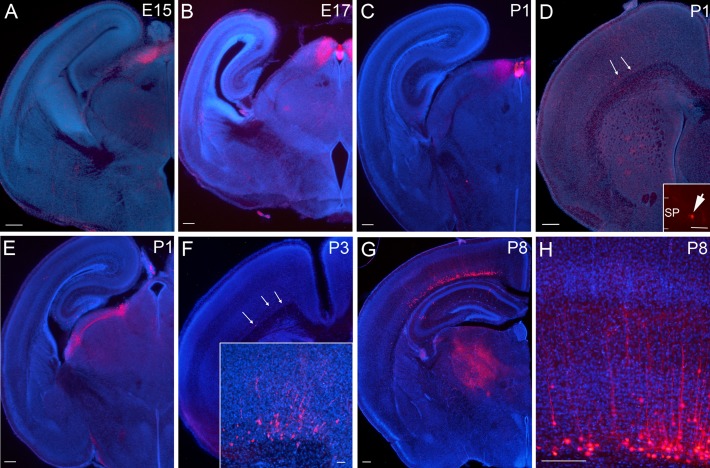

Drd1a-Cre expression in the brain visualized by tdTomato labeling in Drd1a-Cre; Ai14 mouse from embryonic development until P8. (A,B) At E15 and E17, Cre-expressing cells are restricted to a small area of the dorsal thalamus, no Cre+ cells are found in the cerebral cortex. In caudal sections the labeled regions are in contact with the aqueduct, from where they continue anteriorly in a dorsal position. (C–E) At P1, Cre+ cells are most abundant in dorsal thalamus, but a few Cre+ cells are located in the subplate/layer 6b of the anterior medial cerebral cortex (see inset in D). (F) By P3, the cortical layer 6b cell population has expanded in number and extends to more lateral and posterior locations. Cells are also beginning to have a clear pyramidal morphology (see inset in F). (G–H) At P8, cortical Cre+ cells are abundant, with more cells located in medial and anterior cortex. Cells extend projections to higher order thalamic nuclei (G) and dendrites into the overlying cortex (H). Scale bars = 200 μm (A-H) and 50 μm (all insets).